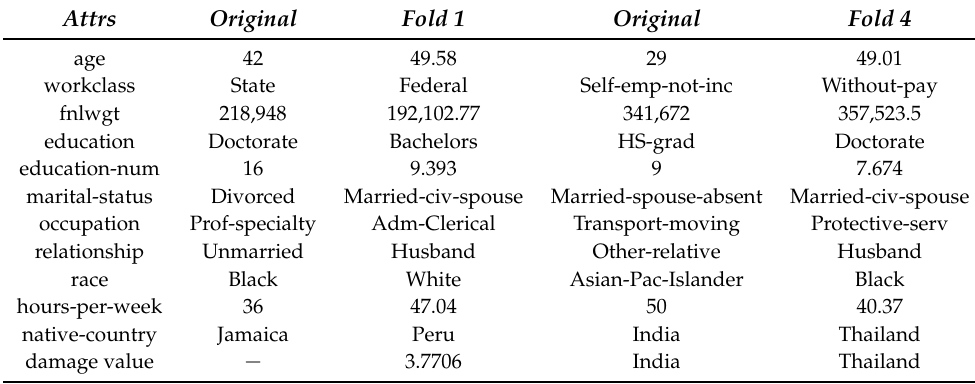
Table A4. Most damaged profiles for α = 0.9875 on the first and the fourth folds. Only the